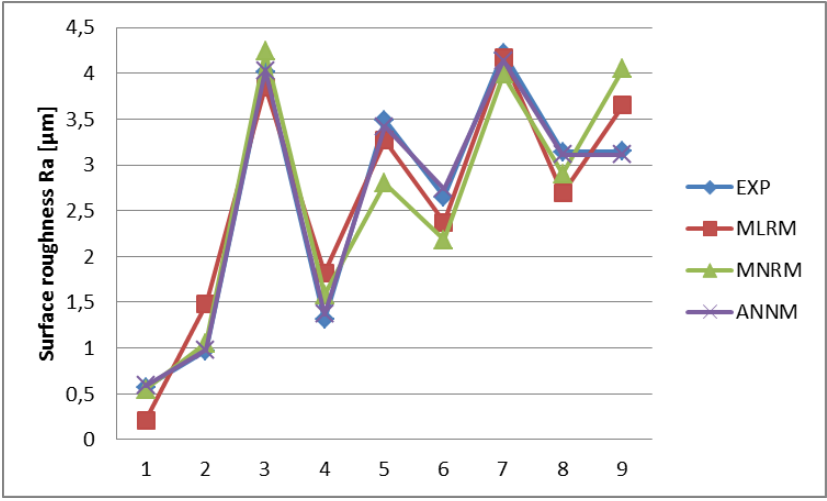
Figure 6. Graphical representation of experiment and models results.